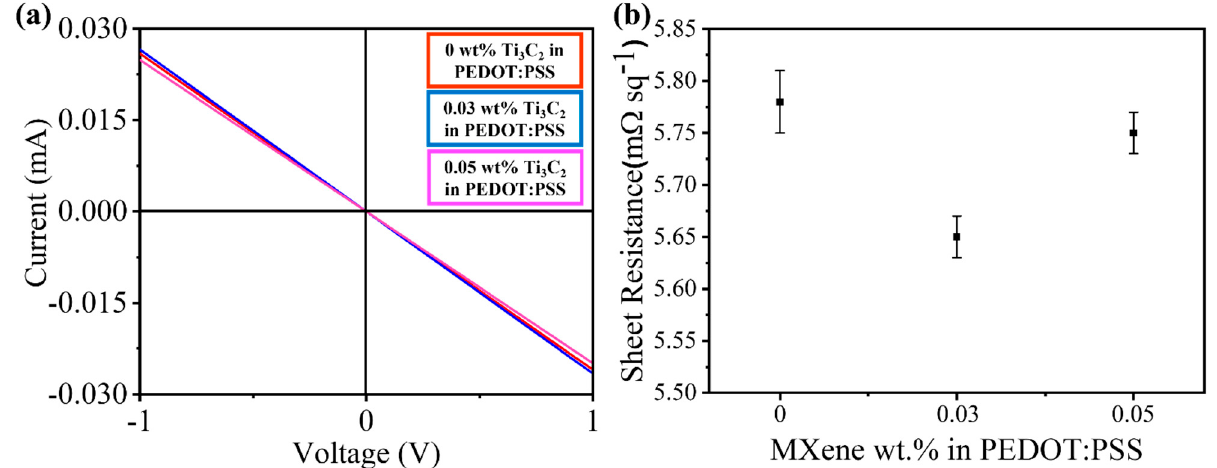
Figure 7. ( a ) I-V measurement, ( b ) Sheet resistance of 0 wt.%, 0.03 wt.%, and 0.05 wt.% Ti3C2Tx-doped PEDOT:PSS.